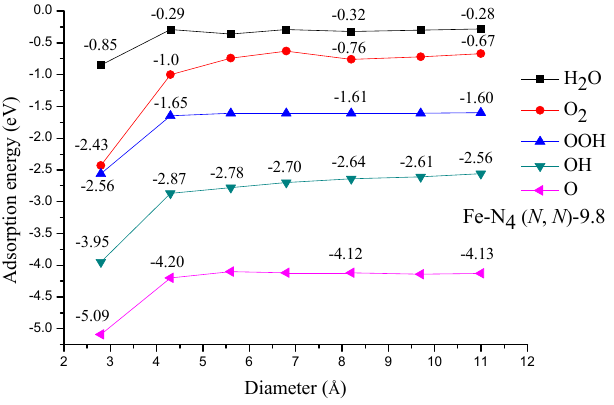
Figure 3. Calculated adsorption energies of the ORR species.